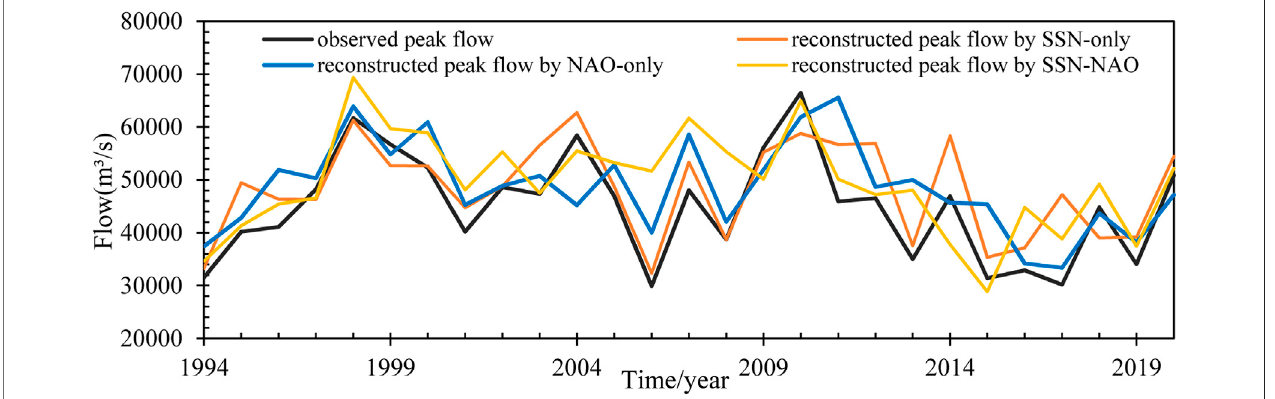
FIGURE 9 | Reconstructed discharge through the BP neural network and observed discharge in the modern period.